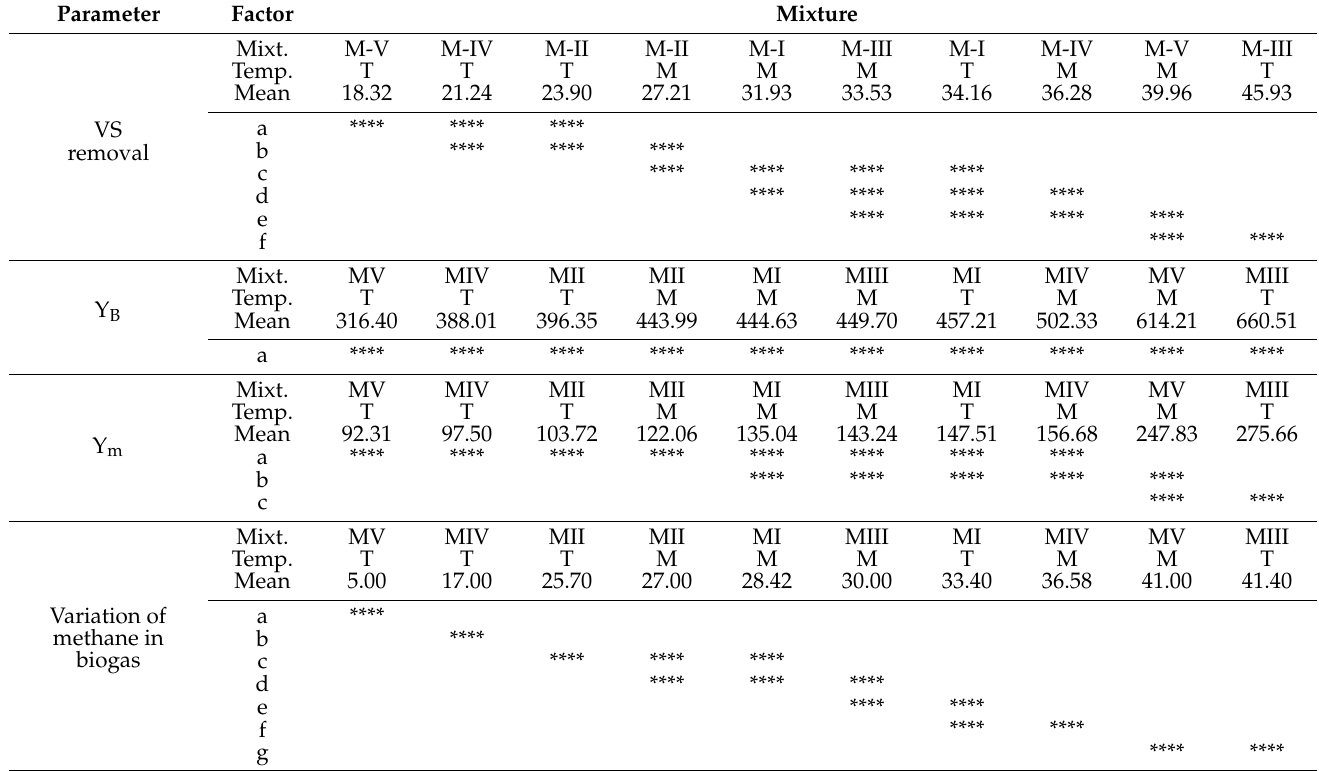
Table 6. Results of the Tukey HSD